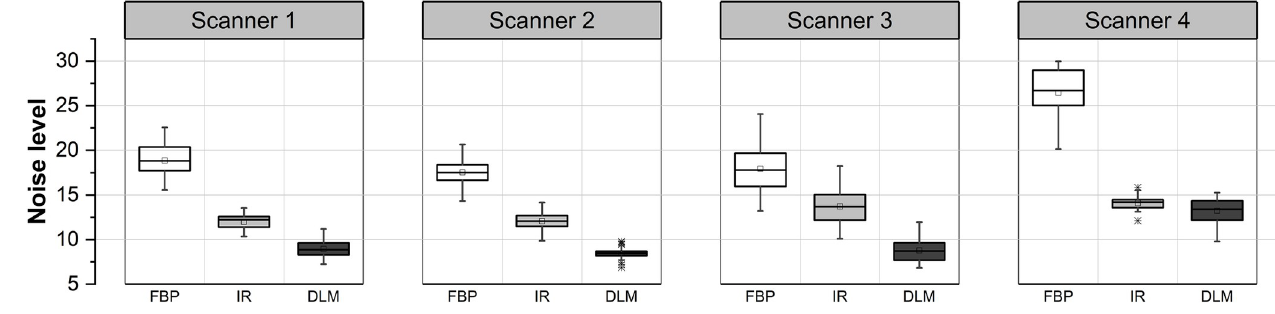
Fig 6. Box plots compare the noise level measurements among the multi-vendor and multi-reconstruction images.